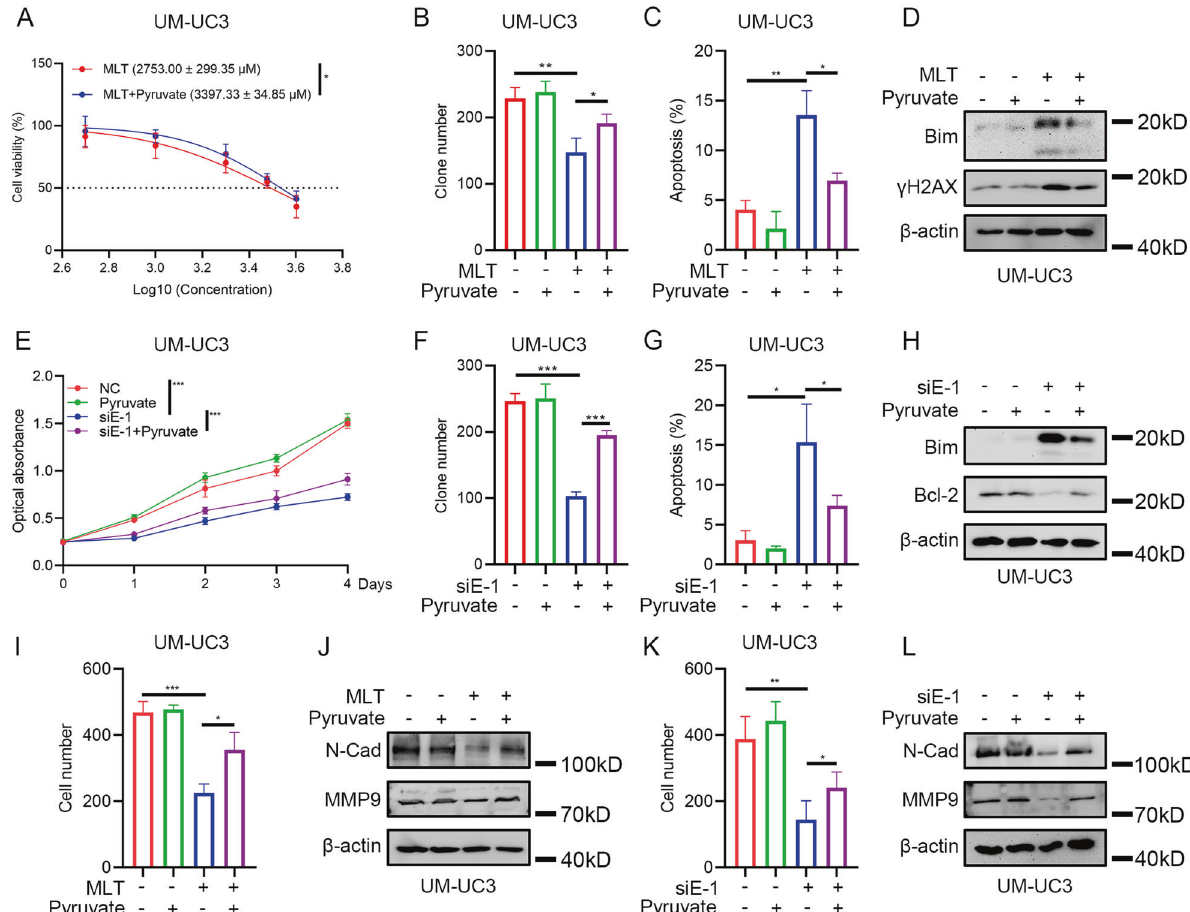
Fig. 3 Supplement of exogenous pyruvate could reverse the inhibitory effect of melatonin treatment or silencing of ENO1 on BLCA cells. A IC50 value of 24 h melatonin treatment on UM-UC3 cells with exogenous pyruvate (3 mM) supplement ( n = 3). B Statistical analysis of clone formation assay of UM-UC3 cells under 48 h melatonin (2 mM) treatment and exogenous pyruvate (3 mM) supplement ( n = 3). C Statistical analysis of apoptotic cells of UM-UC3 cells after 24 h melatonin (2 mM) treatment with exogenous pyruvate (3 mM) supplement ( n = 3). D Western blot assay of apoptosis-related proteins of UM-UC3 cells after 24 h melatonin (2 mM) treatment with exogenous pyruvate (3 mM) supplement. E MTT assay of UM-UC3 cells after silencing ENO1 with exogenous pyruvate (3 mM) supplement ( n = 3), negative control siRNA was added. F Statistical analysis of clone formation assay of UM-UC3 cells after silencing ENO1 with exogenous pyruvate (3 mM) supplement ( n = 3), negative control siRNA was added in “ - ” of siE-1 group. G Statistical analysis of apoptotic cells of UM-UC3 cells after silencing ENO1 with exogenous pyruvate (3 mM) supplement ( n = 3), negative control siRNA was added in “ - ” of siE-1 group. H Western blot assay of apoptosis- related proteins of UM-UC3 cells after silencing ENO1 with exogenous pyruvate (3 mM) supplement, negative control siRNA was added in “ - ” of siE-1 group. I Statistical analysis of transwell assay of UM-UC3 cells after 24 h melatonin (2 mM) treatment with exogenous pyruvate (3 mM) supplement and statistical analysis ( n = 3). J Western blot assay of EMT-related proteins of UM-UC3 cells after 24 h melatonin (2 mM) treatment with exogenous pyruvate (3 mM) supplement. K Statistical analysis of transwell assay of UM-UC3 cells after silencing ENO1 with exogenous pyruvate (3 mM) supplement ( n = 3), negative control siRNA was added in “ - ” of siE-1 group. L Western blot assay of EMT-related proteins of UM-UC3 cells after silencing ENO1 with exogenous pyruvate (3 mM) supplement, negative control siRNA was added in “ - ” of siE-1 group. * p < 0.05, ** p < 0.01, *** p <